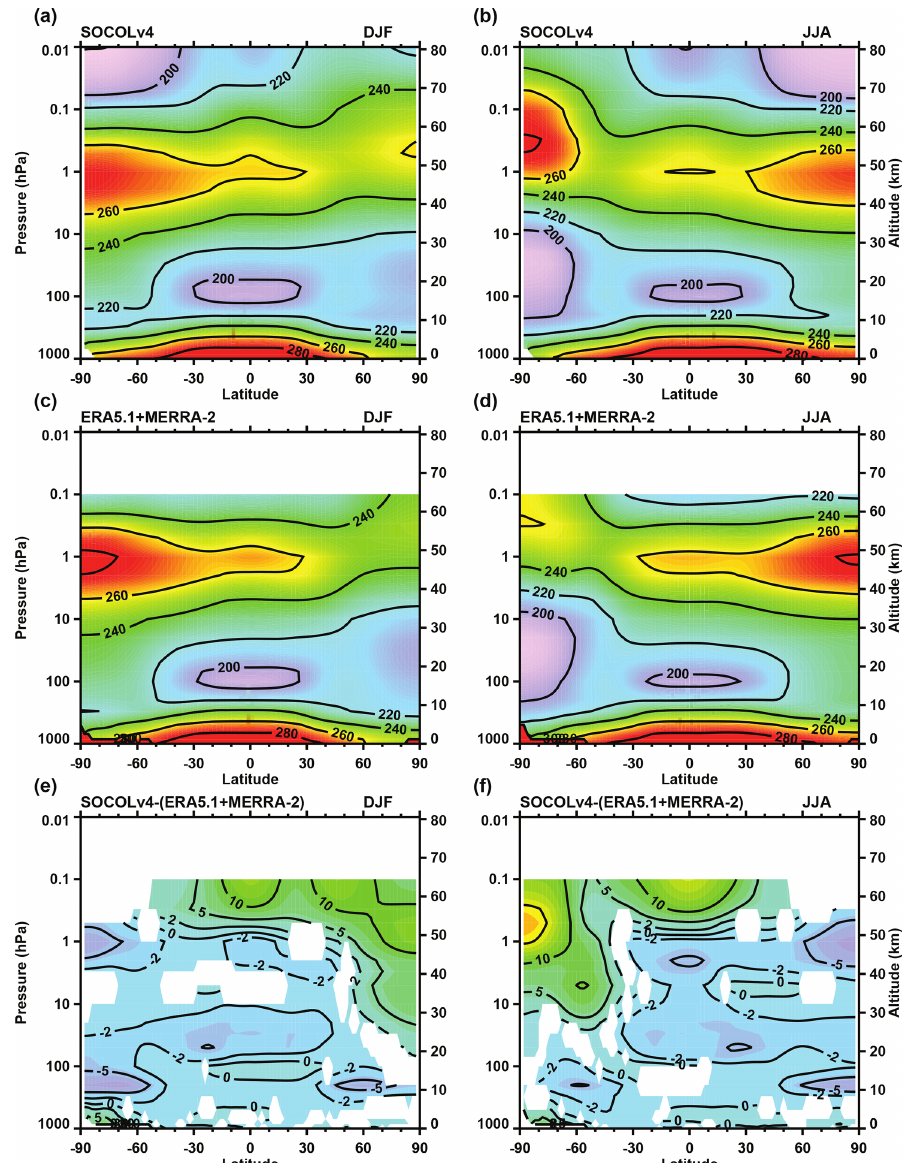
Figure 7. Zonal mean temperature climatology for DJF (a, c, e) and JJA (b, d, f) simulated with SOCOLv4 (a, b) , mean of ERA5.1 and MERRA-2 reanalysis (c, d) , and differences between simulated and reanalysis data (e, f) . Contour intervals for the differences are − 30, − 20, − 10, − 5, − 2, 0, 2, 5, 10, 20, 30, 40K. White areas denote regions where the difference between model and reanalysis data is not statistically significant at the 95% confidence